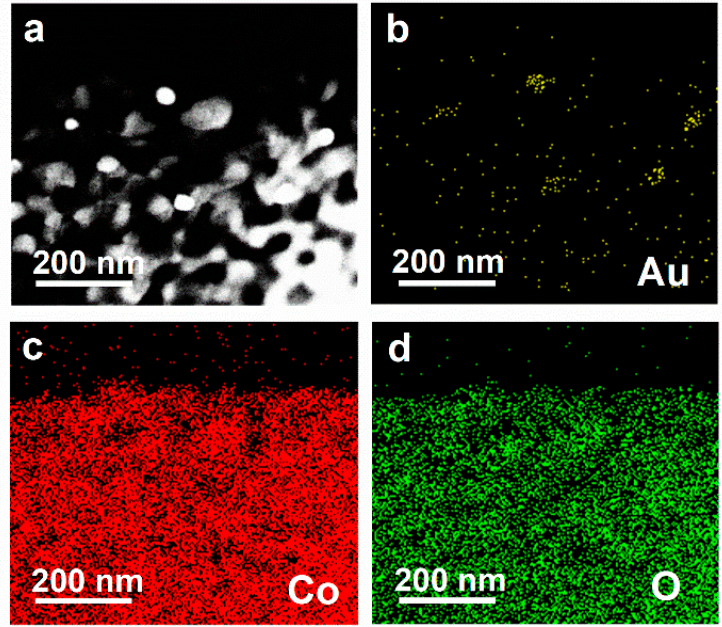
Figure 3. ( a ) Dark-field STEM micrograph of Co 3 O 4 /Au nanocomposites; and STEM-EDS elemental mapping of ( b ) Au, ( c ) Co, and ( d ) O elements.